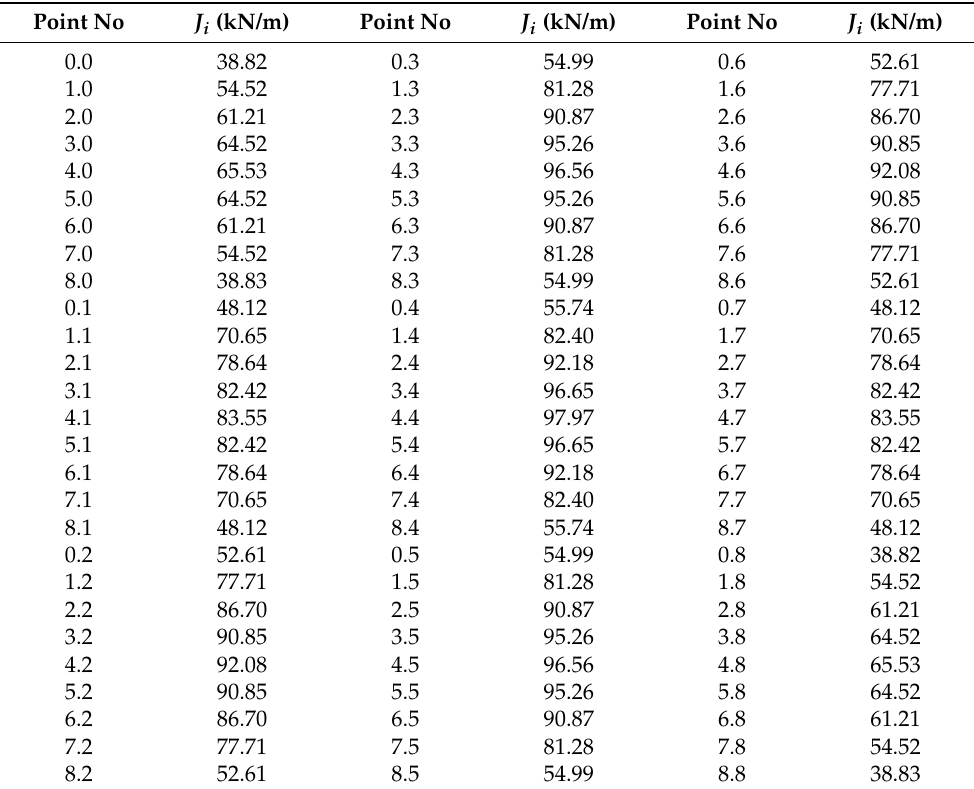
Table 3. The values of the J i parameter in calculation points.